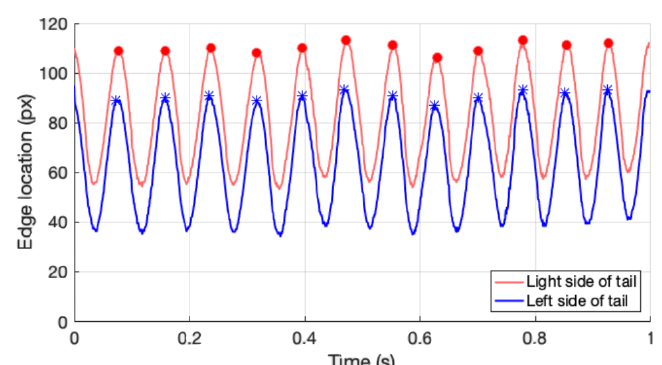
Figure 4. Example tail edge location tracking versus elapsed time during a trial. Peak points used to calculate coiling frequency are noted by circles and squares for the right and left edges of the tail, respectively.